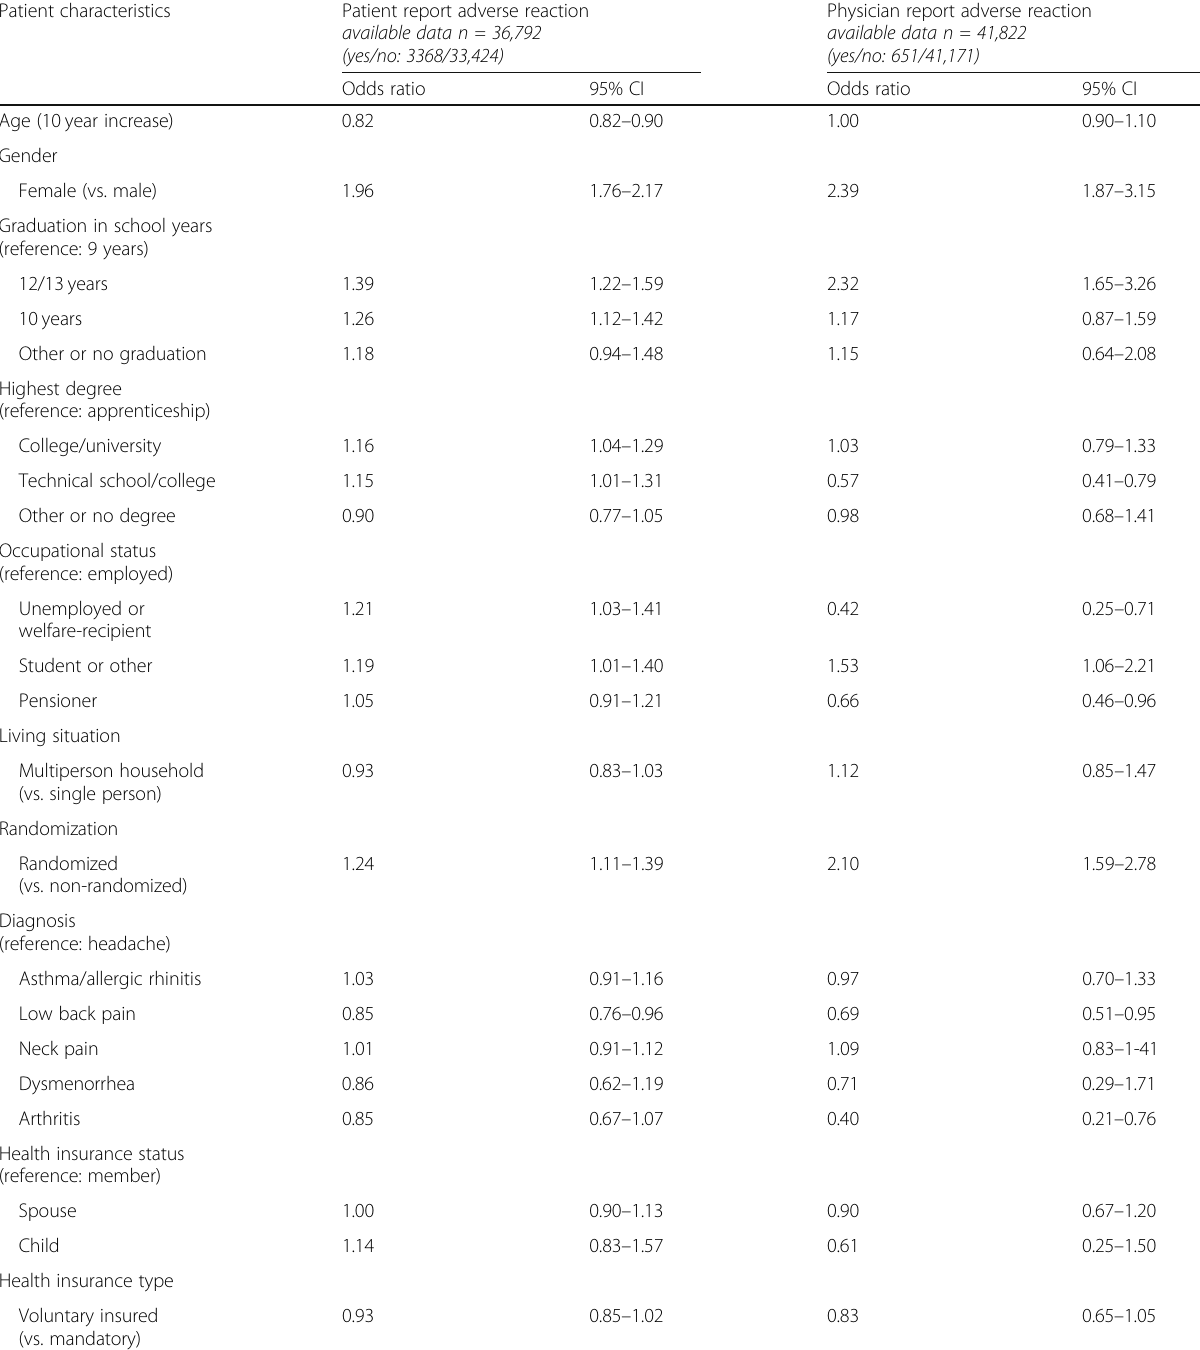
Table 3 Association between patient characteristics and reporting of adverse reaction (yes/no) from patients and physicians (multivariable multilevel logistic regression, yielding adjusted* odds ratios and 95% confidence intervals (CI)) Patient